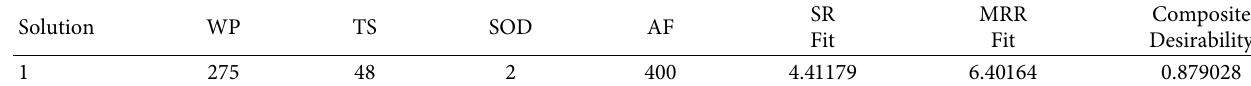
Table 4: Response optimization results of AA5083.